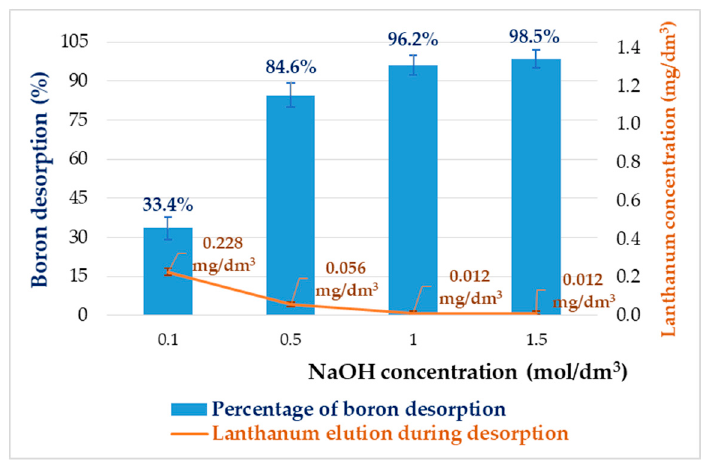
Figure 11. The influence of the NaOH concentration on boron desorption e ffi ciency and on lanthanum elution from La-CTS hydrogel beads.